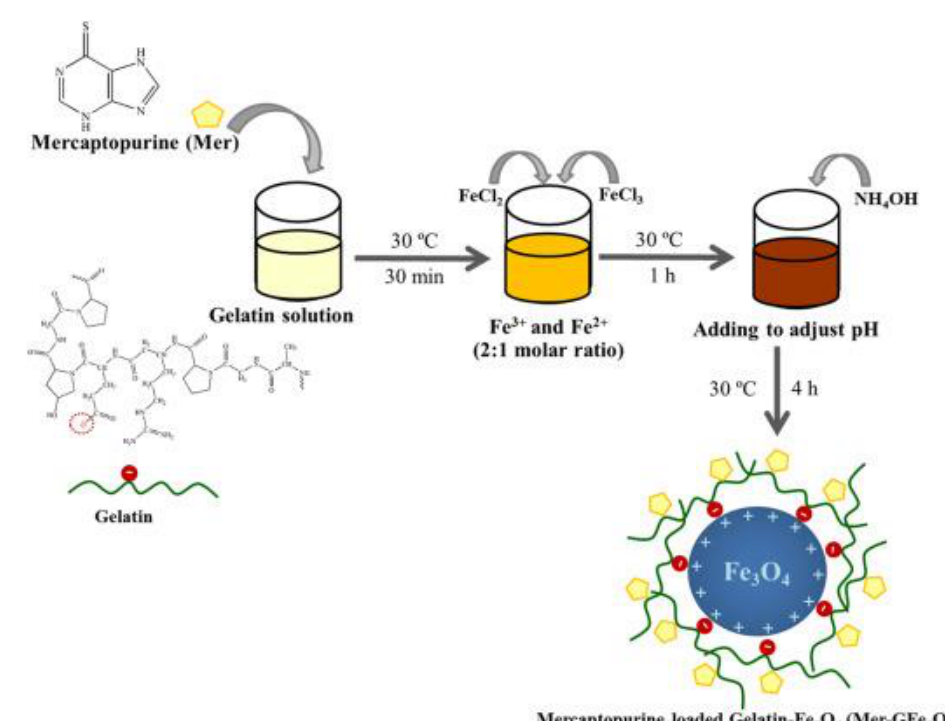
Figure 10. Proposed mechanism interaction between Fe 3 O 4 , gelatin, and loaded drug. Adapted from Sirivat et al. [91].